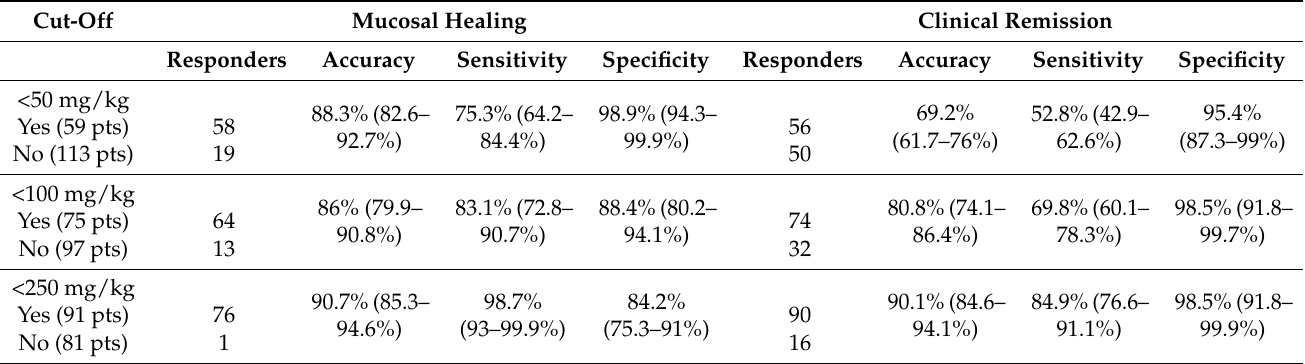
Table 3. Predictive performance for treatment outcomes of post-induction fecal calprotectin levels based on different cut-off points .